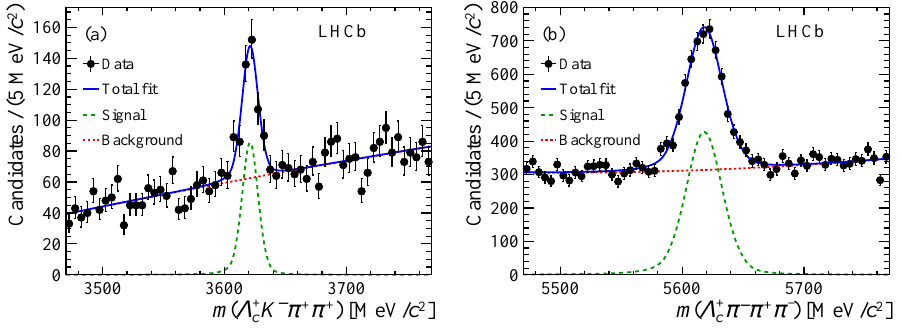
→ Λ + K − π + π + candidates with the corresponding fit cc c